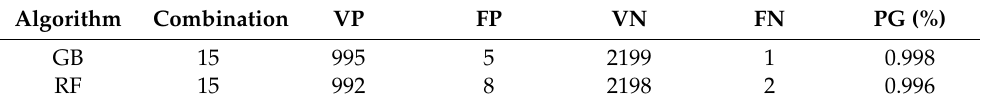
Table 7. Indicators of the performance of algorithms obtained from the confusion matrix for the dry